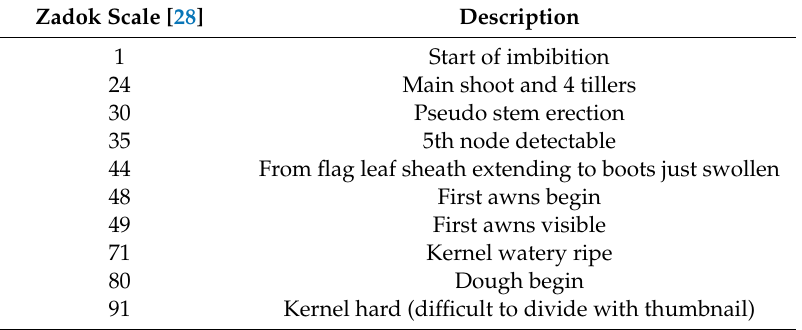
Table 1. Description of growth stage scales.